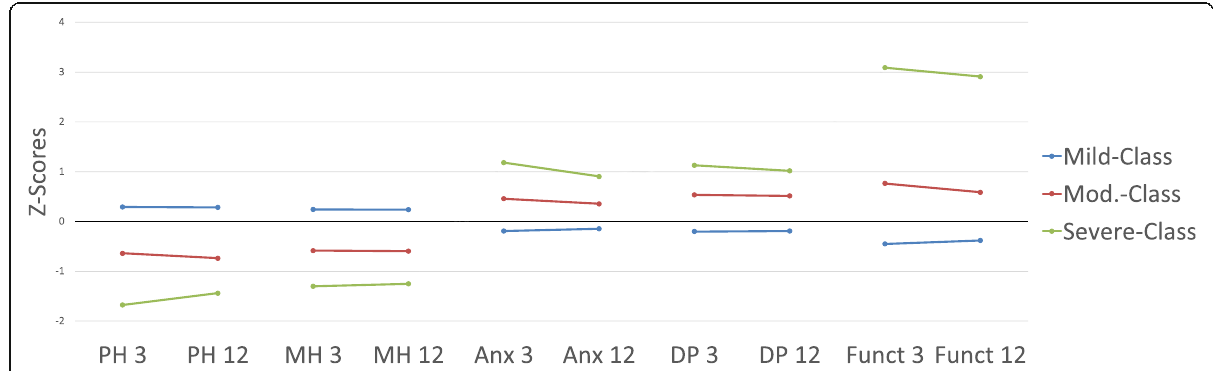
Fig. 2 Patient-reported outcomes after 3 and 12 months clustered in three classes of mild (1), moderate (2), and severe (3) impairment. Physical health (PH) and mental health (MH) were assessed by PROMIS-10, anxiety (Anx) and depressive symptoms (DP) by the PHQ-4, dependencies in functional status (Funct) concerning dressing, toileting and walking by the ICHOM-SSS after 3 and 12 months of diagnosis. Outcomes were clustered by Latent Profile Analysis in three classes (1 = blue, 2 = red, 3 = green). The different values of the items were related to the Z-Score for comparability. Abbreviations: PH = physical health; MH = mental health; Anx = anxiety; DP = depressive symptoms; PROMIS-10 = Patient-reported Outcomes Measurement Information System Short Form-10; PHQ-4 = Patient Health Questionnaire-4; ICHOM-SSS=International Consortium